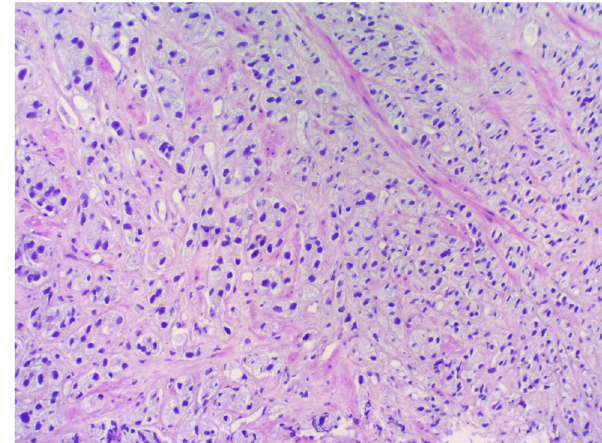
Figure 6. Invasive prostatic adenocarcinoma (H&E stain, X200